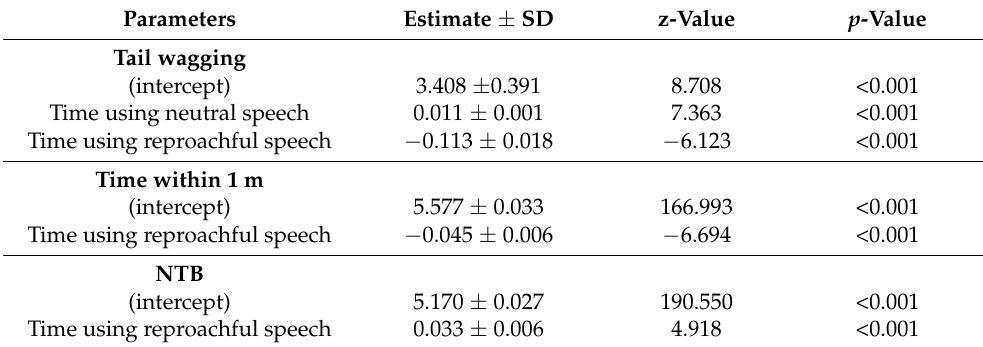
Table 7. Final reduced models (GLMM4) of associations between trainer identity and behavior and time spent tail-wagging; time spent within 1 m of the trainer; non-training behaviors (NTBs), and time spent oriented to the trainer, recorded during all training sessions with shelter and companion dogs 1